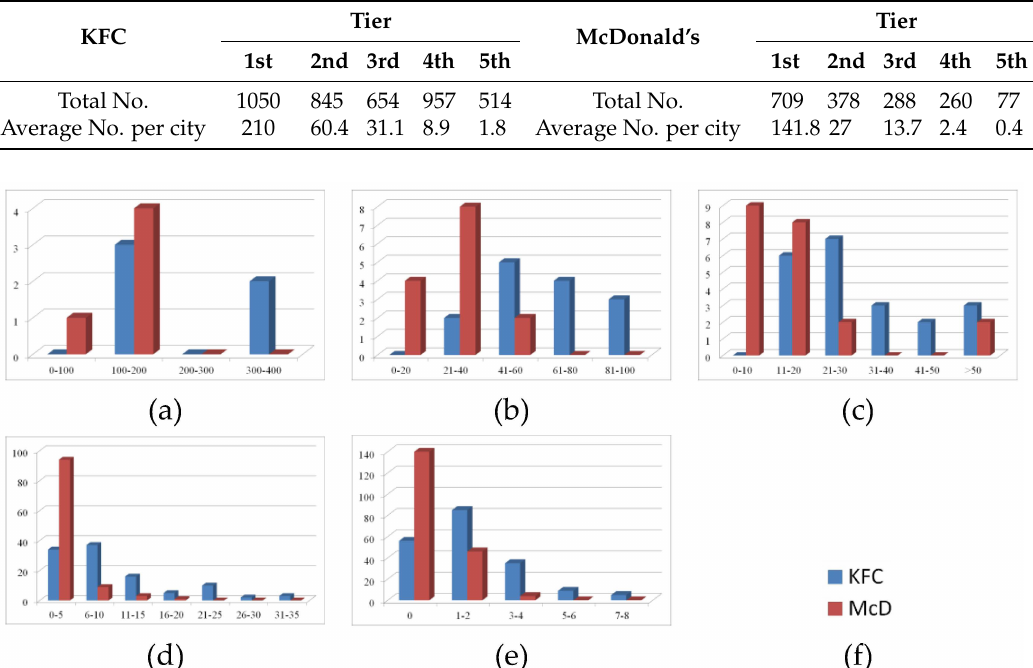
Figure 3. Frequency distributions of KFC and McDonald’s outlets at the urban grading level for the ( a ) 1st-tier cities; ( b ) the2nd-tier cities; ( c ) the 3rd-tier cities; ( d ) the 4th-tier cities; and ( e ) the 5th-tier